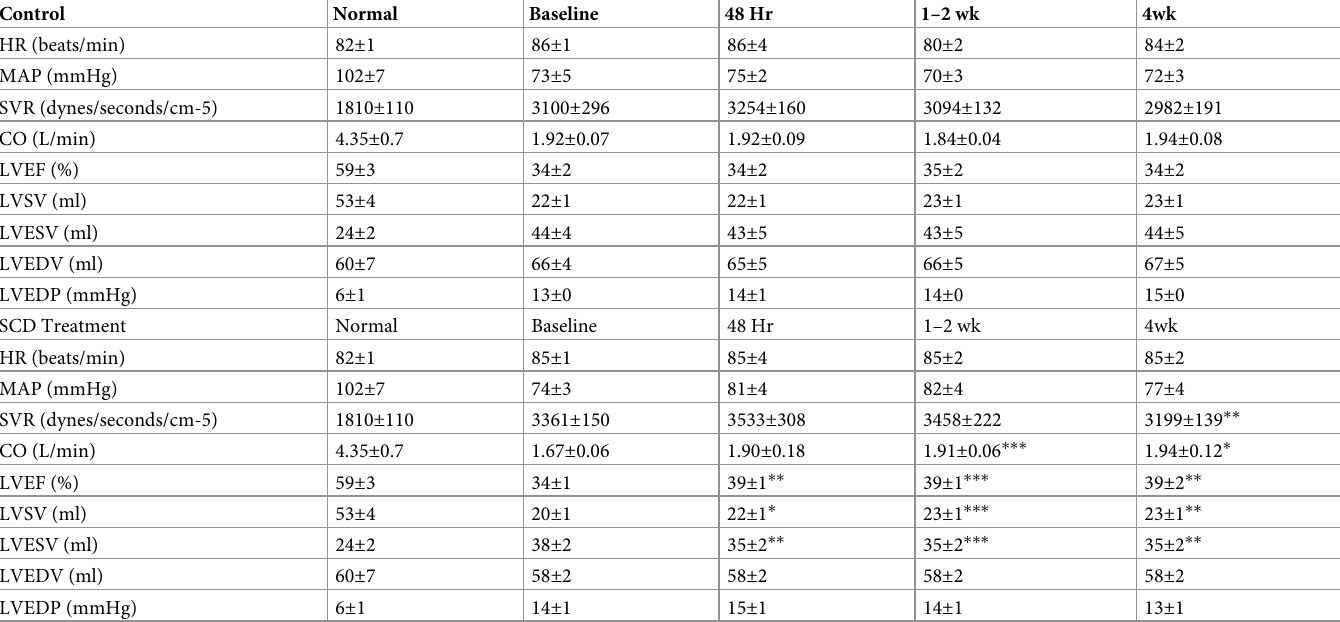
Table 2. Cardiac parameters in HF dogs.